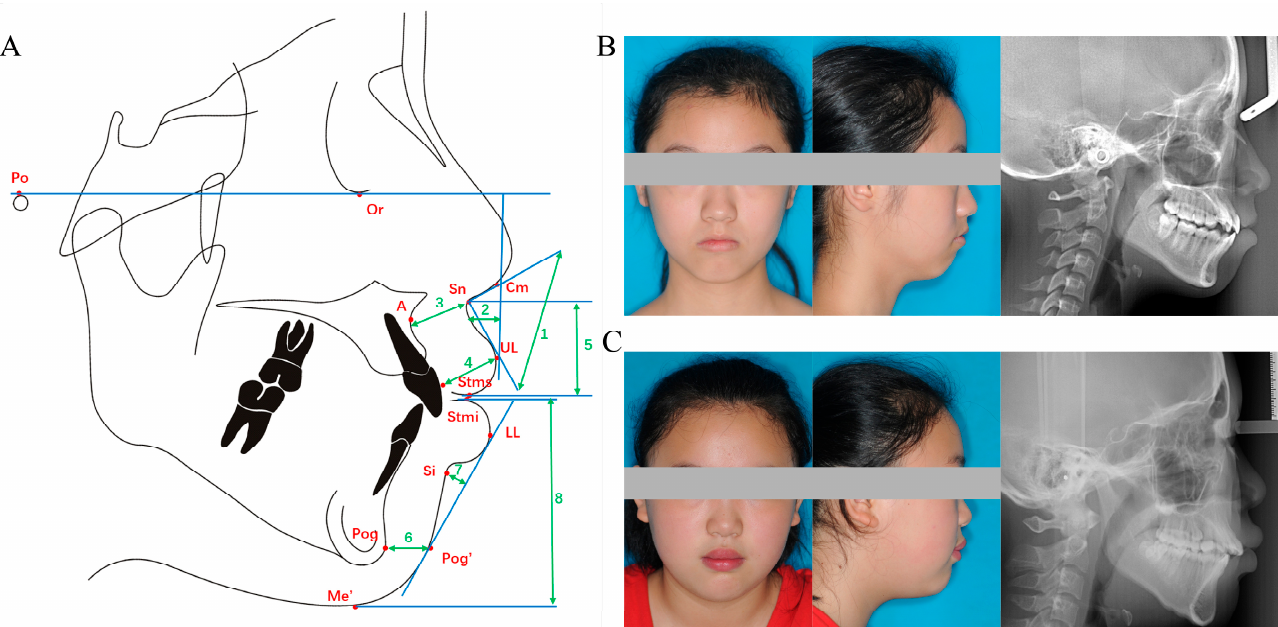
Figure 2. Schematic diagrams of the eight lip characteristics used in the present study and representative patients’ profiles. ( A ) The description of eight lip characteristics. 1: Nasolabial angle, 2: Superior sulcus depth, 3: Basic upper lip thickness, 4: Upper lip thickness, 5: Upper lip length, 6: Soft pogonion thickness, 7: Inferior sulcus depth, 8: Lower lip length. ( B ) A representative underweight patient profile. ( C ) A representative overweight patient profile. Table 1. Cephalometric landmarks used in this study.